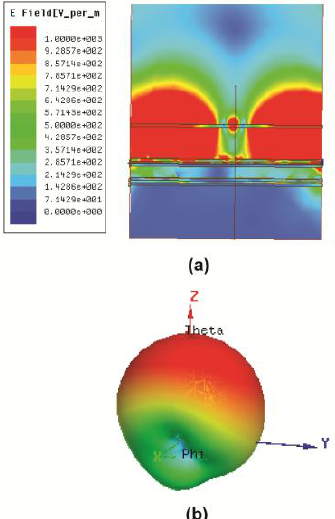
Figure 7: a) Electric field distributions in the computational domain and b) 3D radiation pattern at the resonant frequency